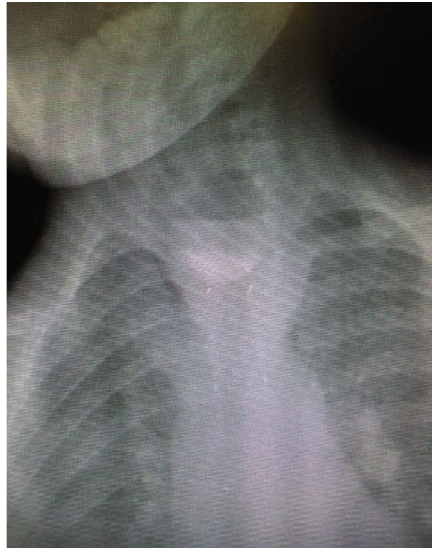
Figure 1: Esophageal graphy is showing no passage.